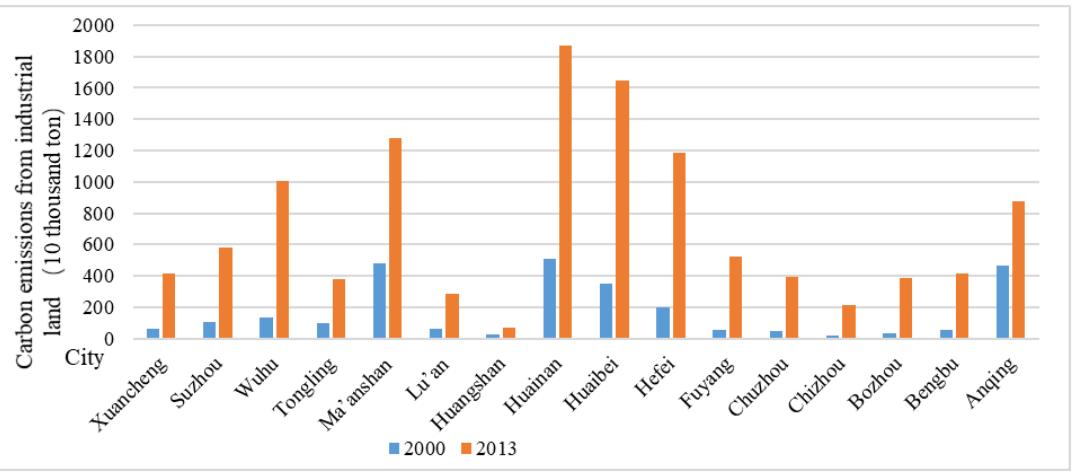
Figure 5. CEIL in 16 prefectural cities in Anhui Province in 2000 and 2013.